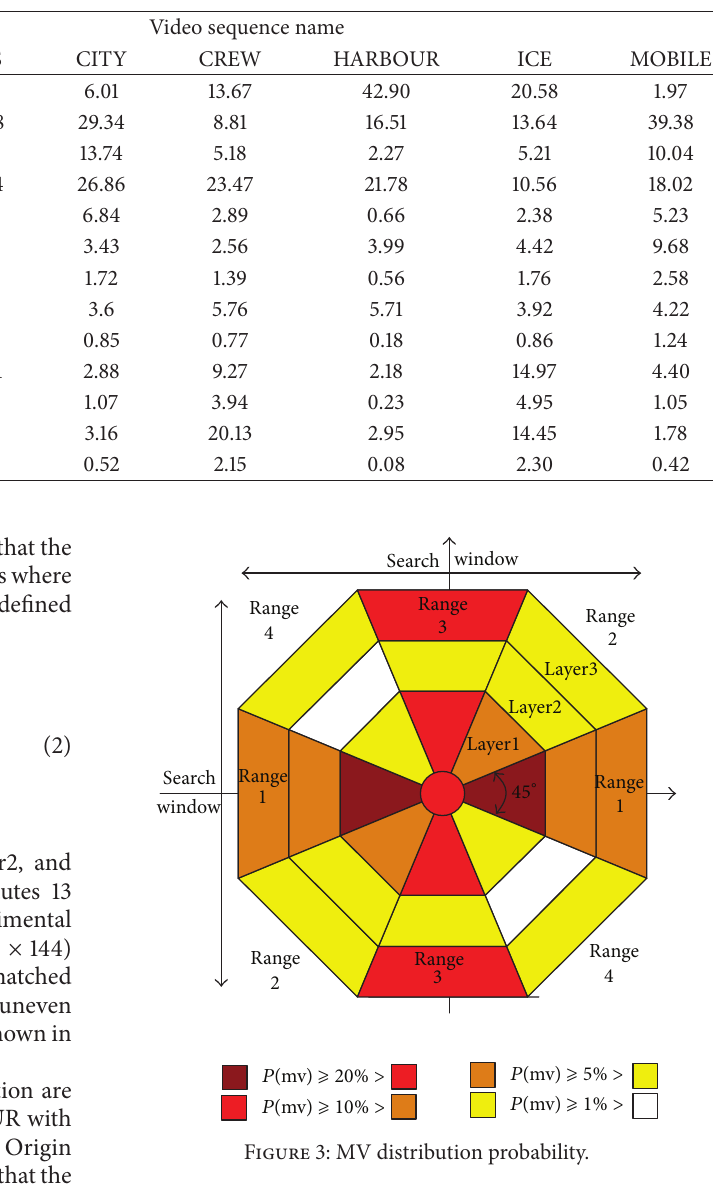
Table 1: MV distribution probabilities of different video sequences.